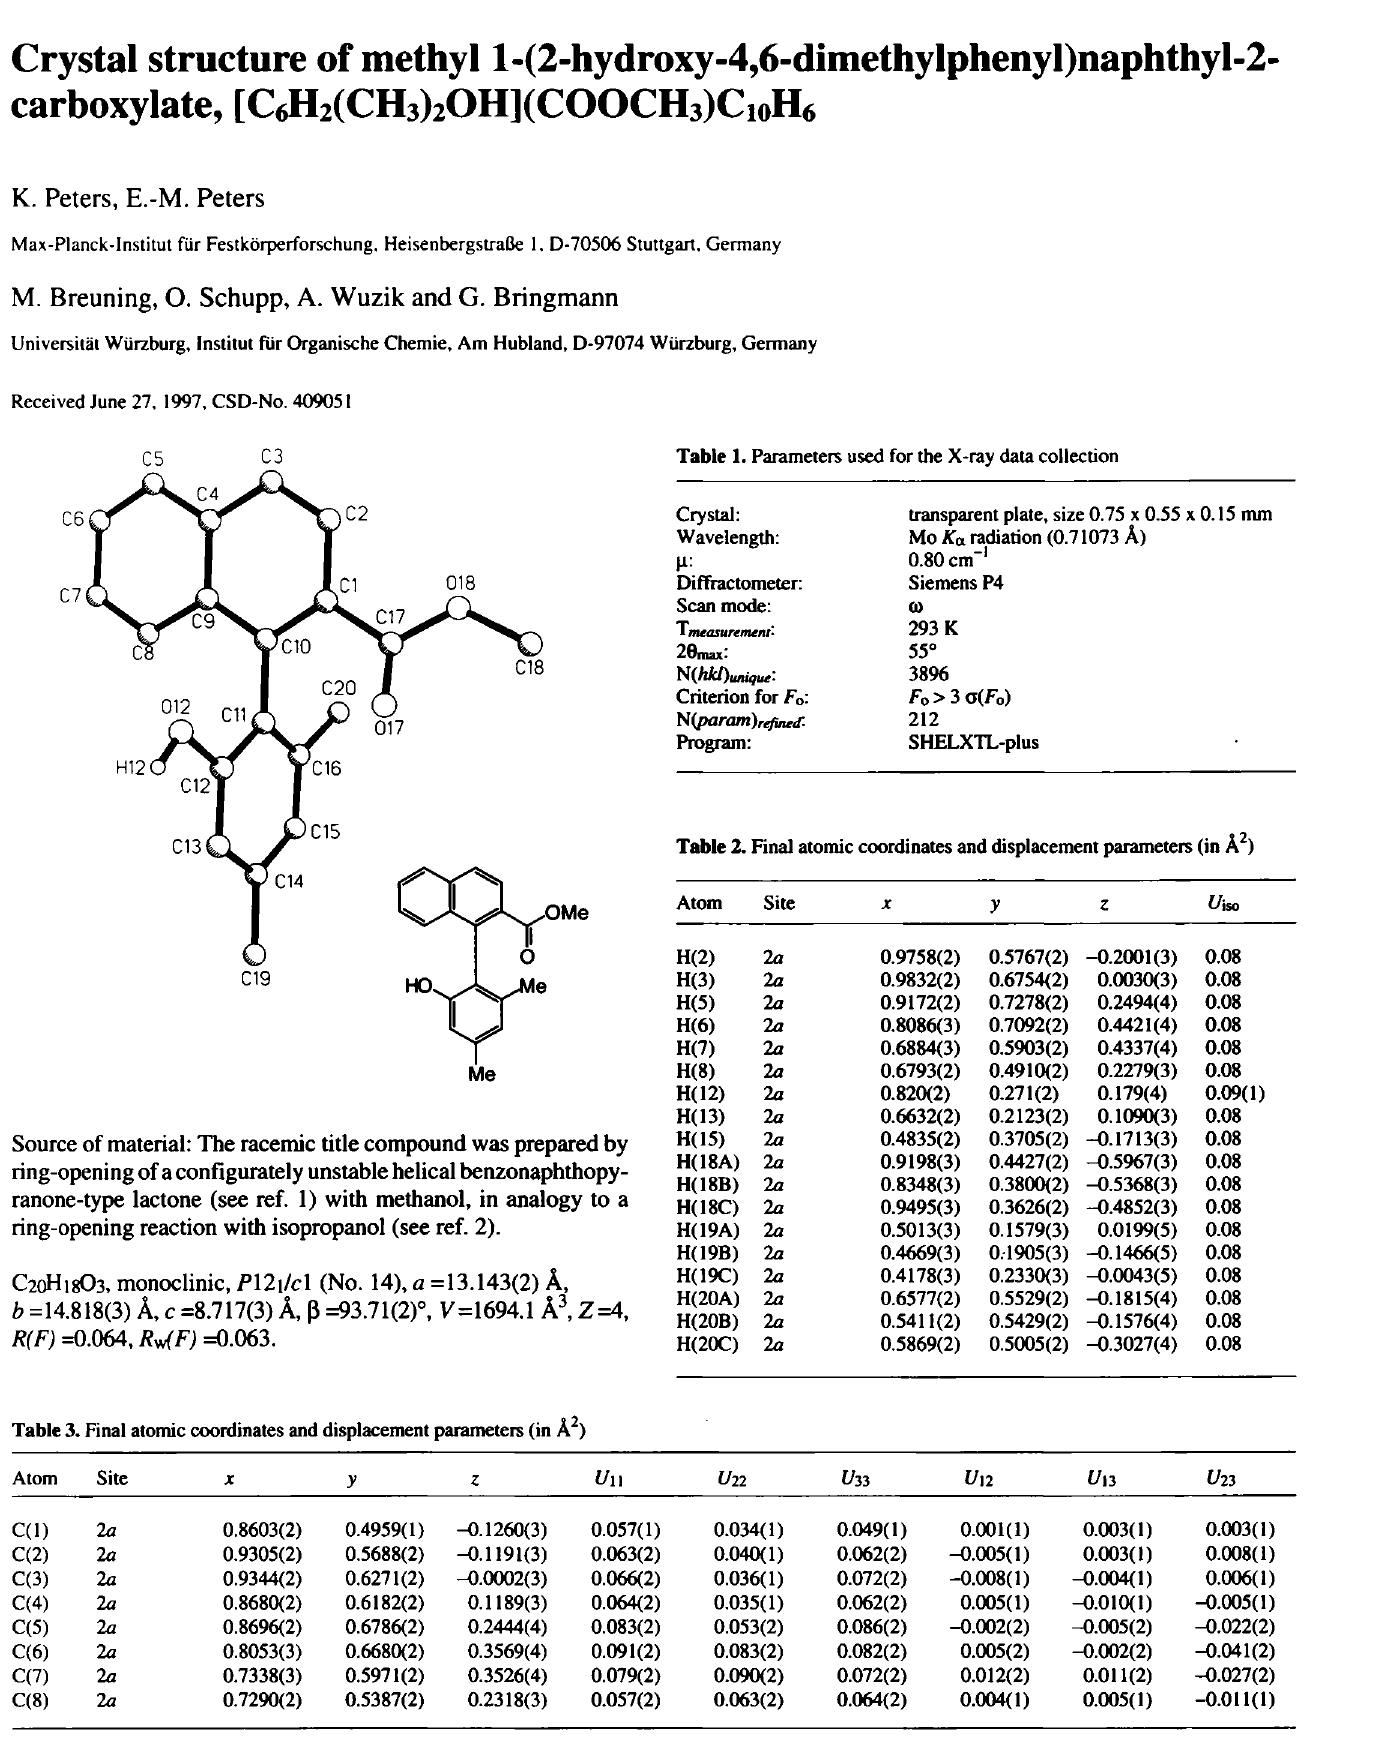
Table 1. Parameters used for the X-ray data collection Crystal: